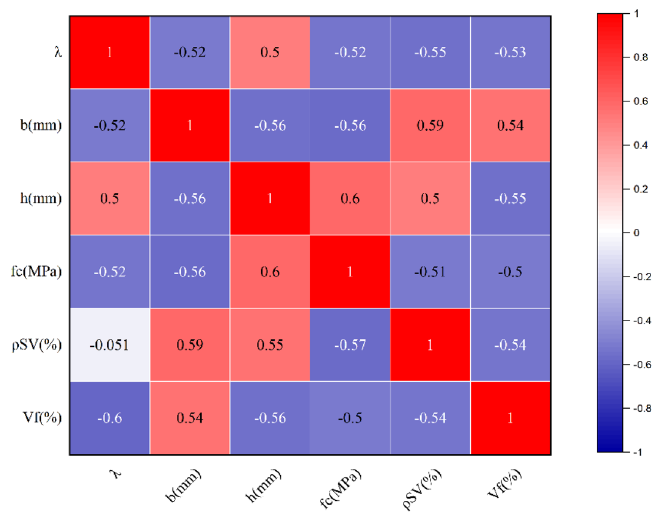
Figure 7. Correlation coefficient matrix of input parameters.